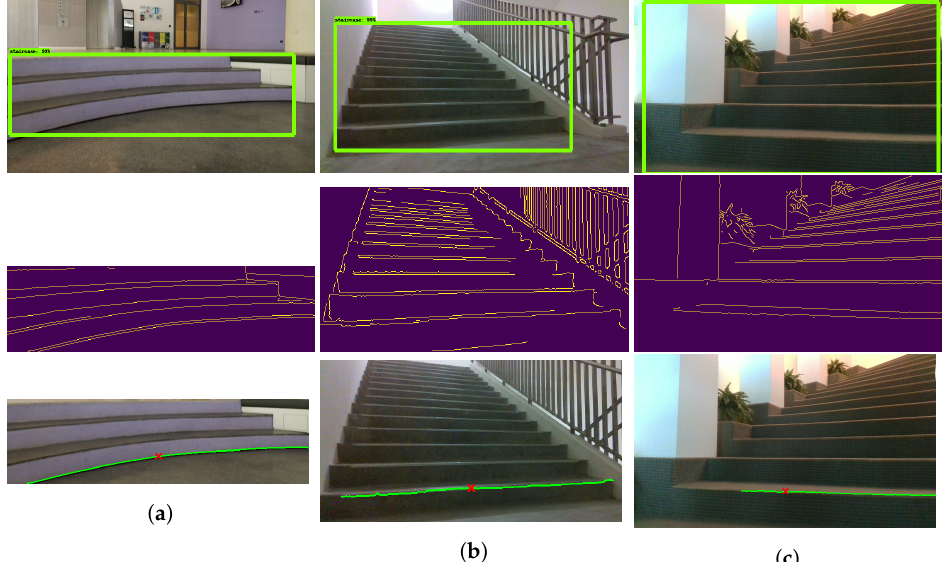
Figure 13. First Step Detection. From top to bottom: Staircase detection, Edge detection inside the bounding box, Contour and midpoint detection. The red cross represents the center point of the staircase. ( a ) curved stair case, ( b ) straight staircase, ( c ) cross view of straight